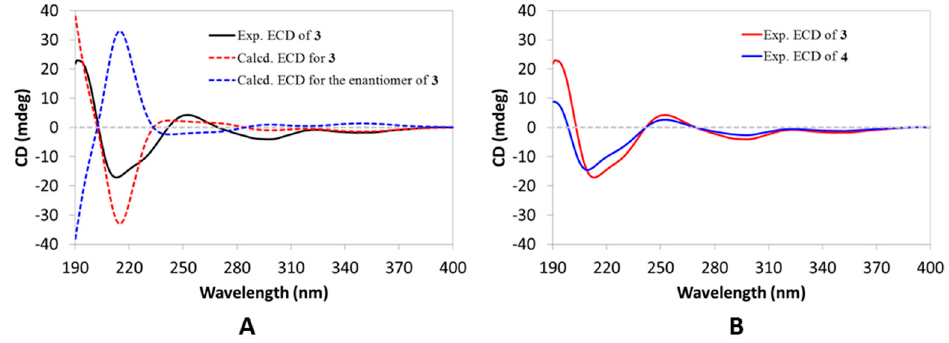
Figure 4. ( A ) Experimental ECD spectrum of Compound 3 (black) compared with the calculated ECD spectra of Compound 3 (red) and its enantiomer (blue). ( B ) Experimental ECD spectra of Compound 3 (red) and Compound 4 (blue).